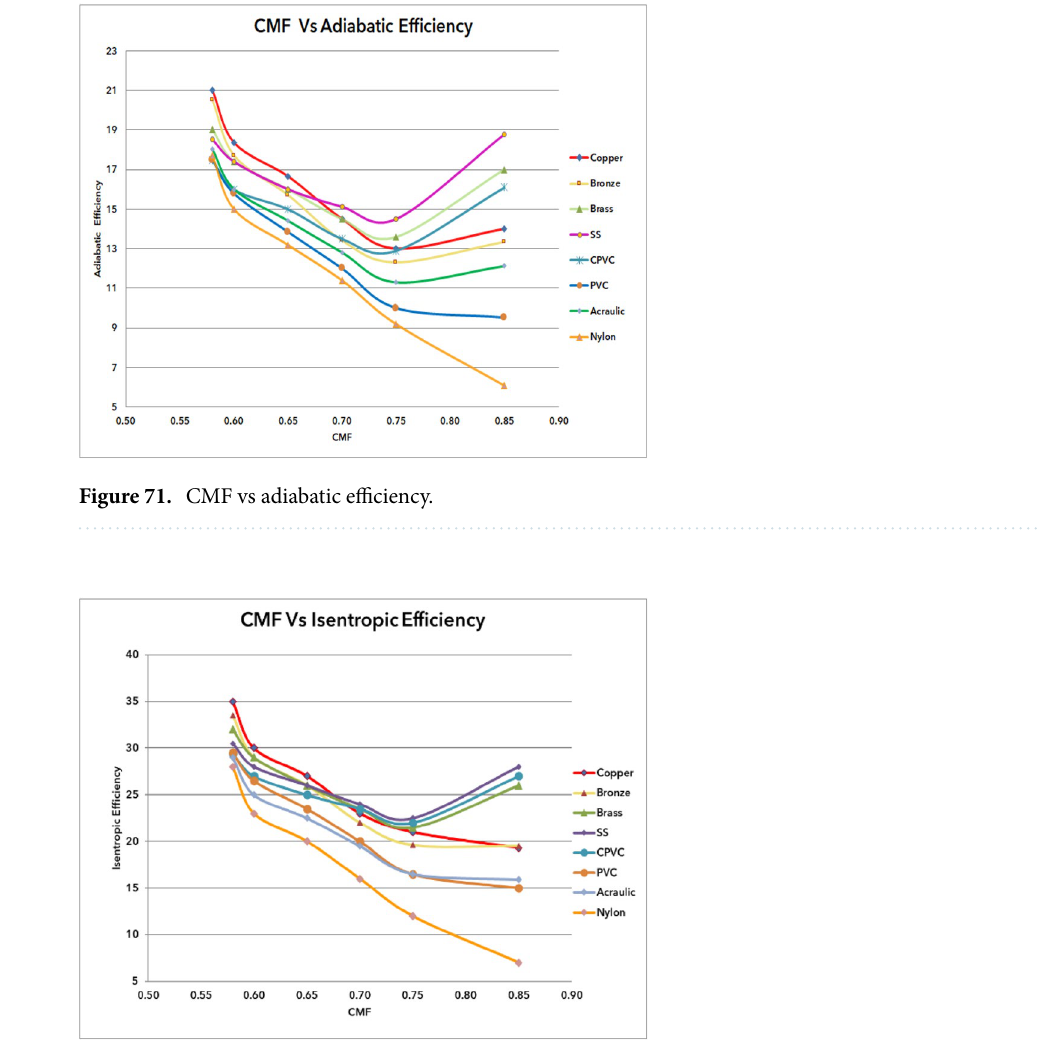
Figure 72. CMF vs isentropic efficiency.